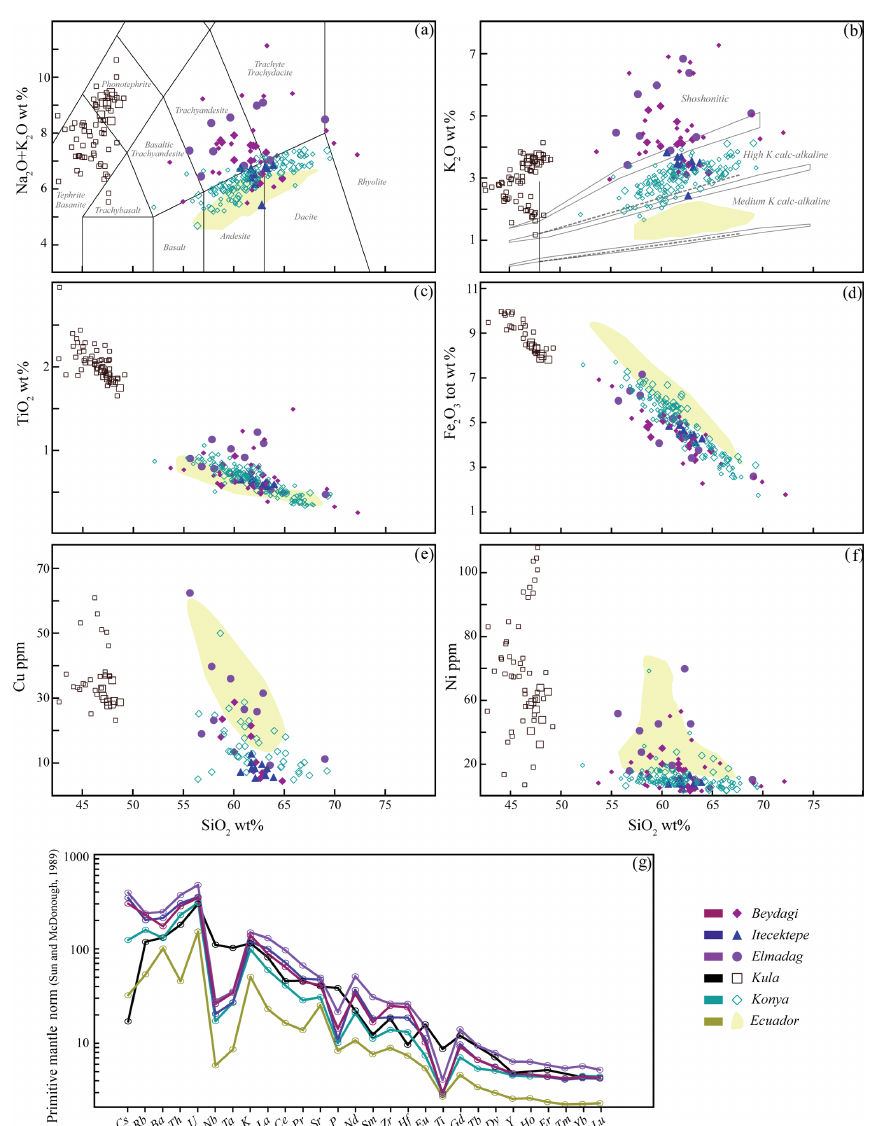
Figure 3. Major (a–d) and trace (e–h) element variations with SiO 2 for the different study areas, illustrated by a different shape and colour. Smaller size symbols correspond to datasets obtained from other studies (Beydagi – Karao ˘ glu et al., 2010; Kula – Alici et al., 2002; Aldanmaz, 2002; Aldanmaz et al., 2015; Dilek et al., 2010; Ercan et al., 1983; Konya – Temel et al., 1998; Korkmaz et al., 2017). For comparison purposes whole rock chemistry from Ecuador has been illustrated as a field in the graphs (a–f) . Spider graph (g) showing the solid mean trace element distribution for the different study areas. For the dataset, see Tables 1–3 from Georgatou and Chiaradia